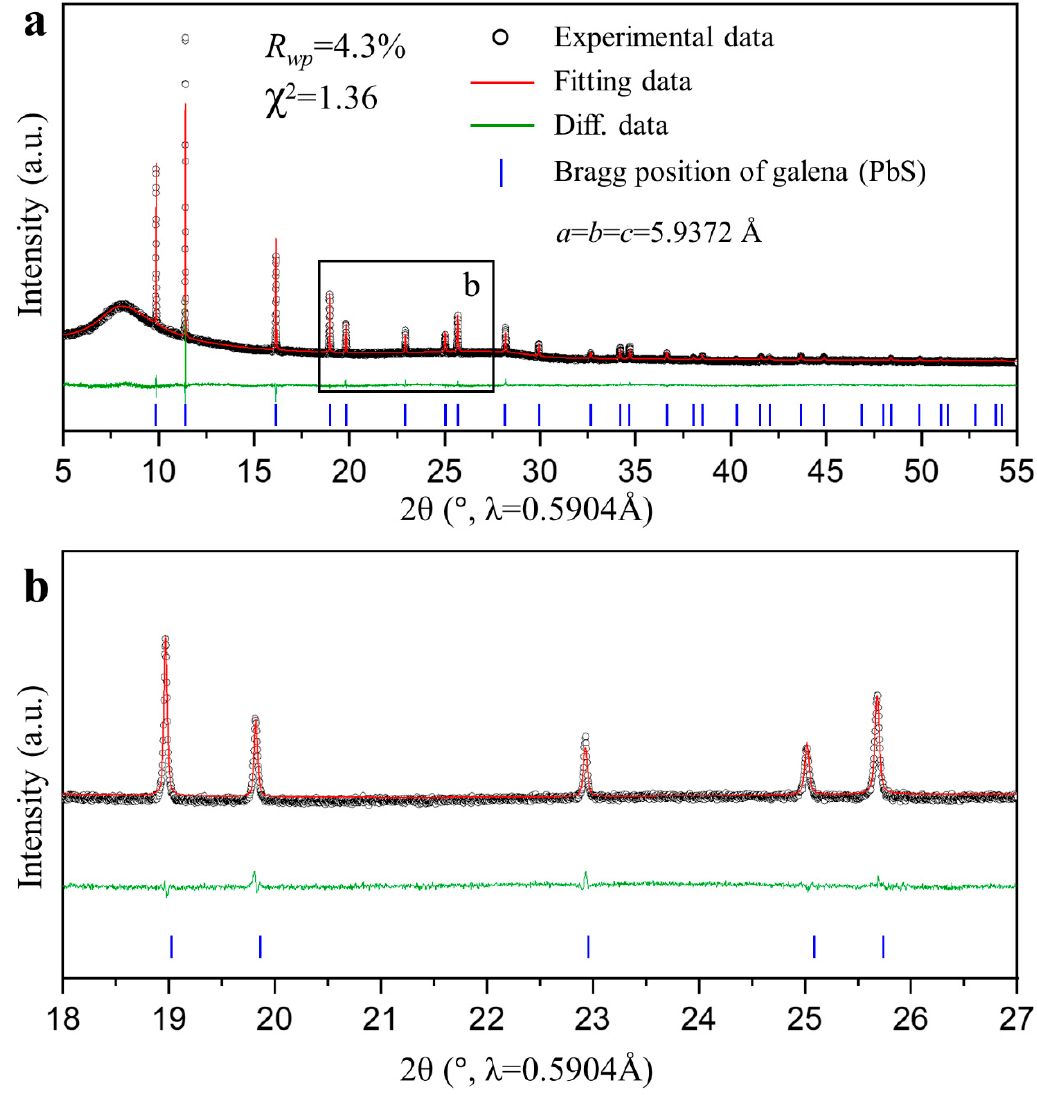
Figure 5. Rietveld refinement of the first dataset from the in - situ PXRD experiment.